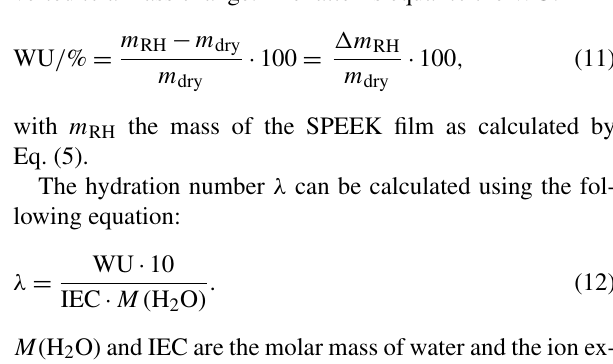
Figure 9. Hydration number λ and proton conductivity σ of SPEEK (DS = 0.5) at 30 ◦